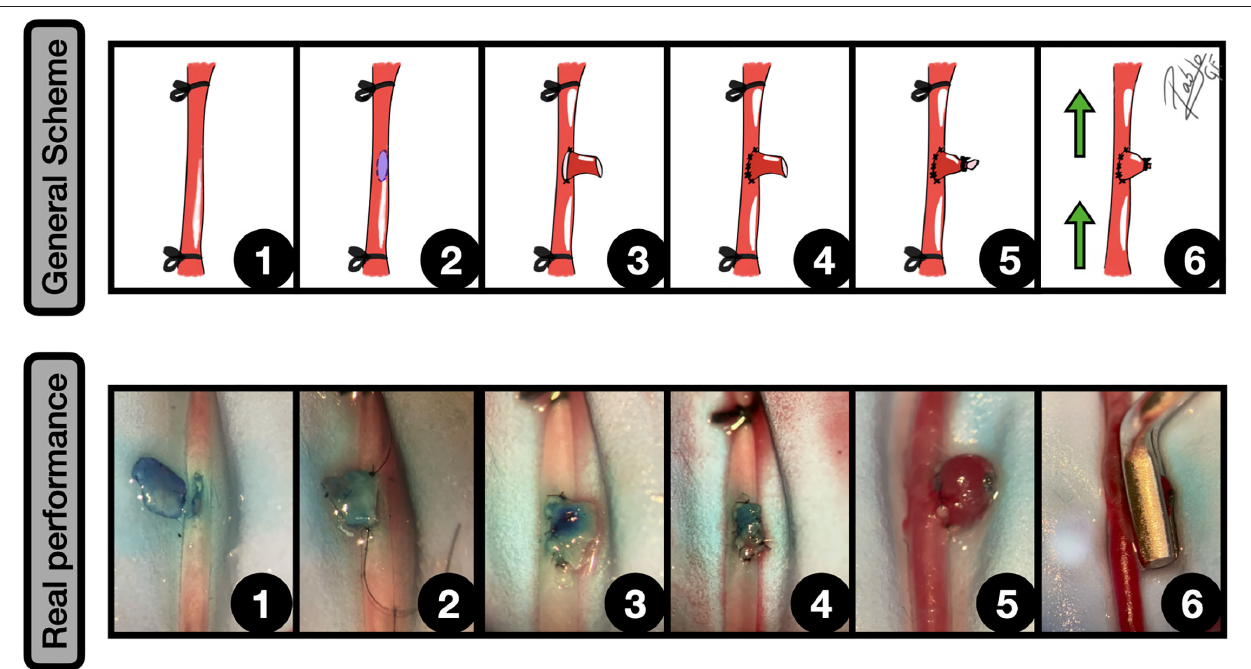
FIGURE 4 | End-to-side graft placement. General scheme: 1: CCA exposure and proximal and distal clamping; 2: Lateral wall excisional arteriotomy of the CCA; 3: The vein graft is placed against the arteriotomy edges, and the two first anchoring knots are made; 4: End-to-side anastomosis between the graft and CCA is completed; 5: The free lumen of the graft is occluded; 6: After clamping releasing an inflow can be observed into the aneurysm. The green arrows indicate the blood flow direction. Real performance: 1: Excisional arteriotomy on the antero-lateral wall of the CCA. A blue-dried venous graft harvested from a jugular vein is on the left; 2: The graft is fixed to the arteriotomy by a couple of anchoring knots; 3: The arteriotomy is fully anastomosed to the graft in an end-to-side fashion; 4: The free lumen of the graft is occluded by an uninterrupted suture; 5: After releasing the clamps an inflow is observed into the venous graft, simulating a sidewall aneurysm; 6: The aneurysm is clipped, preserving the parent vessel